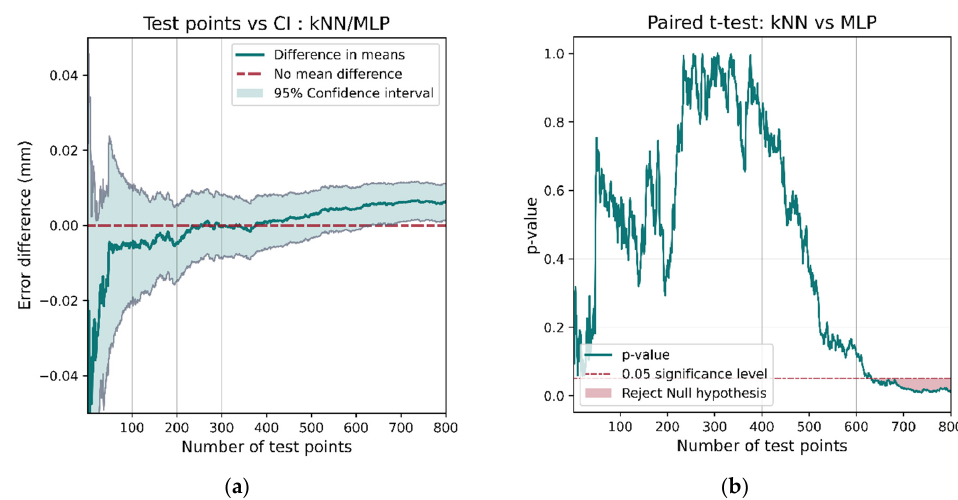
Figure 26. The t-test between the k-NN and MLP models does indicate a performance difference but only after more than 600 test points have been assessed. This demonstrates the need for a large data set when making robust comparisons between models. If less than 600 points had been used for testing, then the confidence interval ( a ) would include 0, the p - value ( b ) would be larger than 0.05, and the hypothesis that there was no difference in performance would not be rejected.